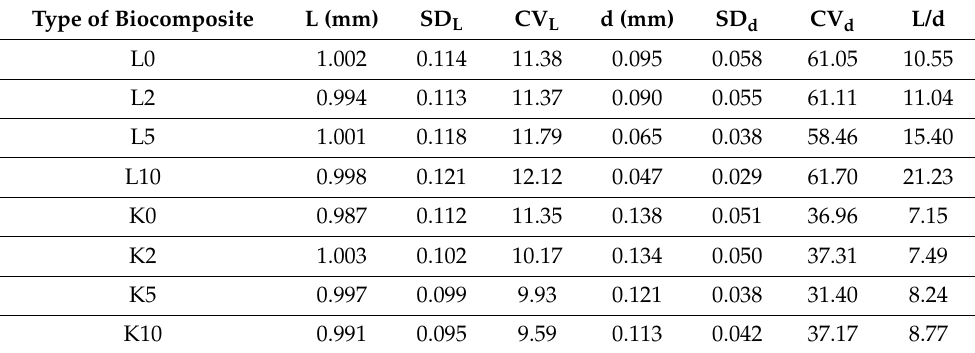
Figure 5. Example photograph of cellulose fibers for which the length and diameter were measured. Table 3. Average value of hemp and flax fiber length and diameter as well as the shape factor in statistical